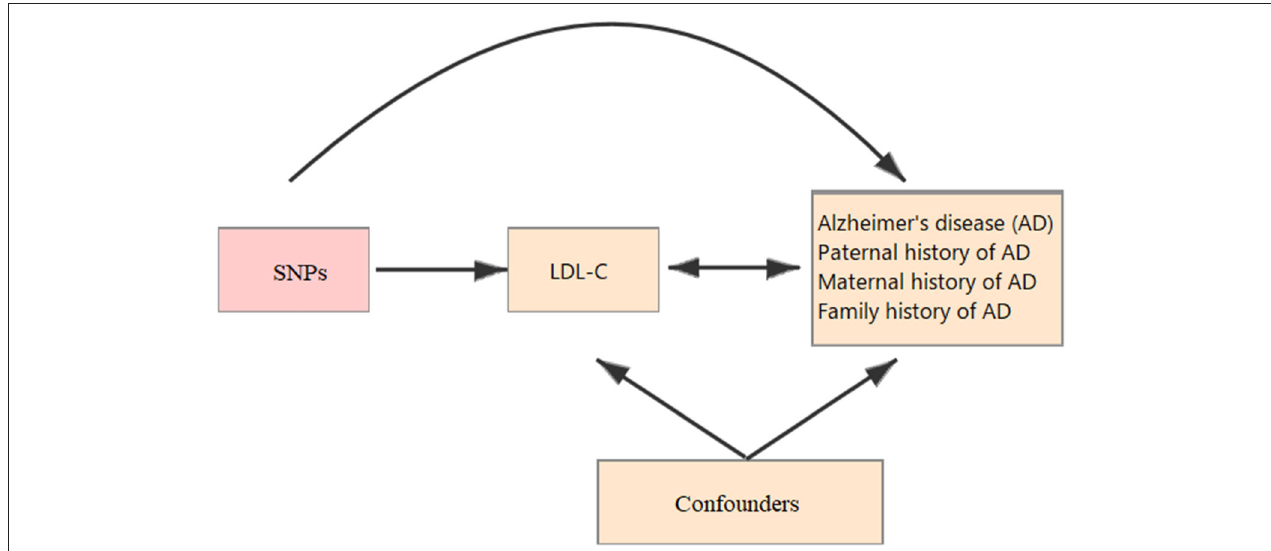
FIGURE 1 | Schematic representation of a Mendelian randomization (MR) analysis. We selected SNPs which associated with low-density lipoprotein cholesterol (LDL-C) and the corresponding effect for these single nucleotide polymorphisms (SNPs) was estimated based on the risk of Alzheimer’s disease (AD) obtained from a large cohort of European